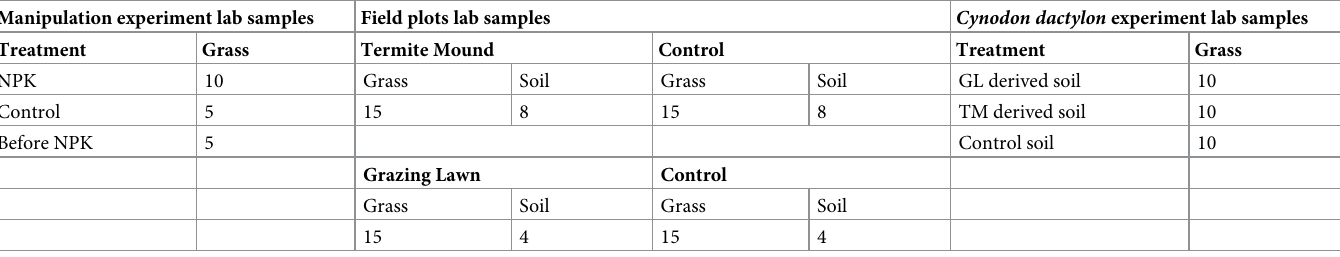
Table 1. Sample sizes (N) for laboratory analyzed samples from manipulation experiment, observation experiment and C . dactylon experiment, indicating number of samples that were involved in our grass analysis, their control and their initial measurement before fertilization. In the manipulation experiment column, we report the number of grass samples that were analyzed in each treatment, while in the field plots column, we report the number of soil and grass samples around each ter- mite mound, grazing lawn as well as their respective controls that were involved in the analysis. Furthermore, in our C . dactylon pot experiments column, we report the number of grass samples that were analyzed from pots with soils derived from grazing lawns, termite mounds and controls. Fertilizer was applied once in the month of Jan- uary, 2017. Laboratory analyses of grass and soil samples included nitrogen and phosphorus contents. GL = grazing lawn, TM = termite